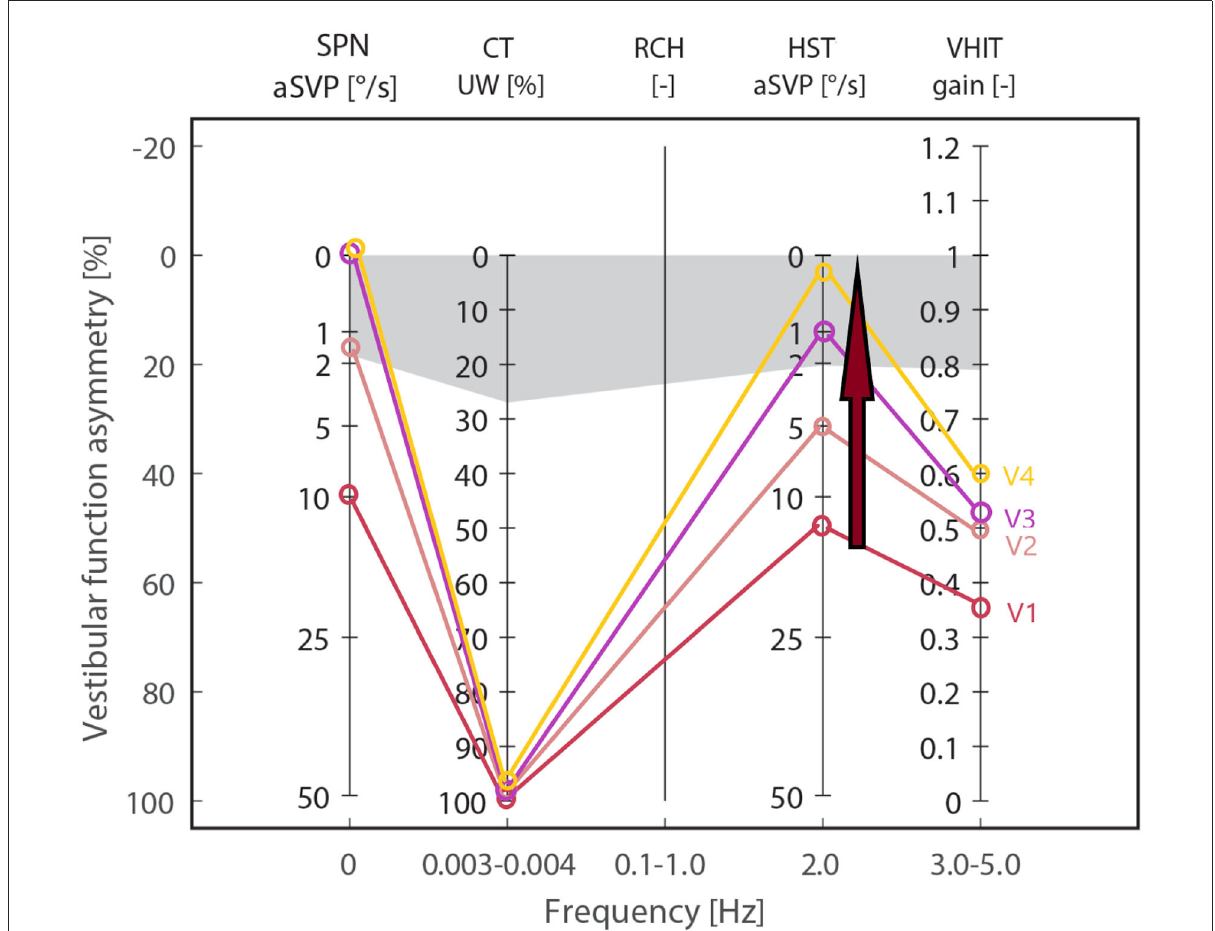
FIGURE1 Estimated Vestibulogram (EVEST) for the neuronitis group, affected side: Median values from each visit are depicted to visualize an HSN-intensity decreasing trend (red arrow) during 2 years of follow-ups (visits V1–V4) from the abnormal to control group level. The same trend is observed in SPN till normalization. HST, head-shaking test; SPN, spontaneous nystagmus; vHIT, video head impulse test; CT, caloric test; gray zone corresponds to abnormal cut-offs calculated from a control group.